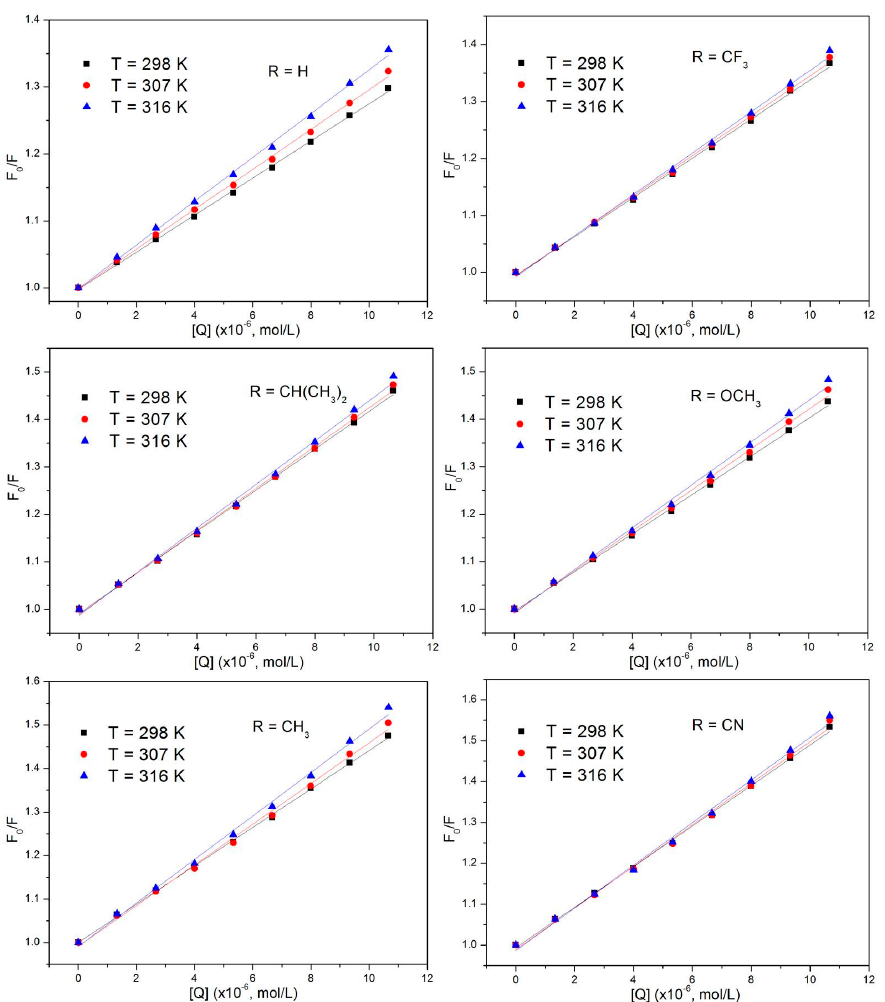
Figure 3. The Stern-Volmer plots for the fluorescence quenching of HSA by PDQL.